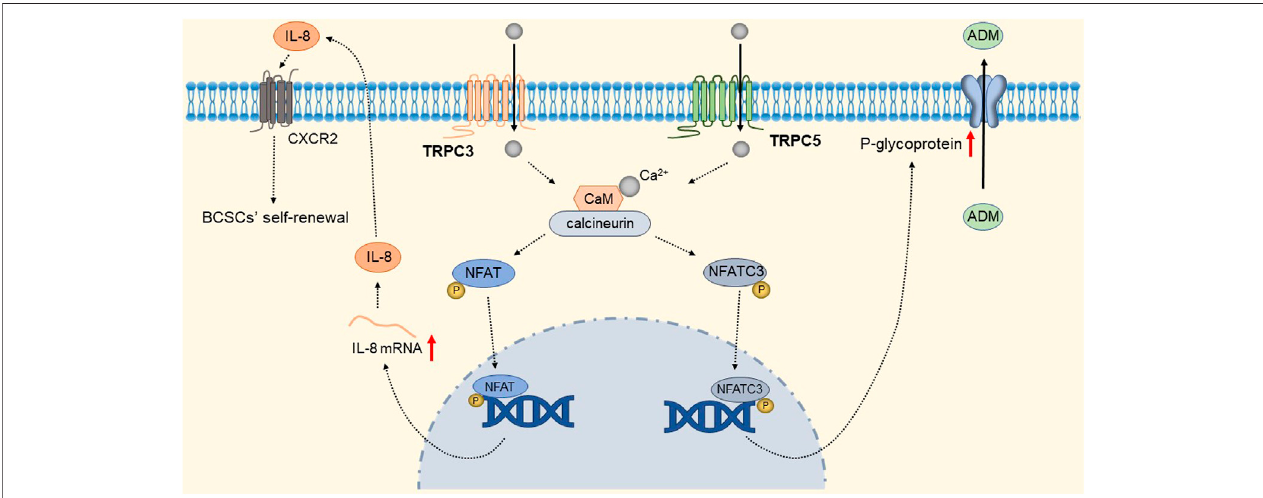
FIGURE 10 | TRPC3andTRPC5mediatebreastcancercellproliferationanddrugresistance.Ca 2+ entrythroughTRPC3andTRPC5channels,viacalmodulin-calcineurin dependent NFAT signal pathway, upregulating IL-8 and P-gp expression respectively. IL-8 mediates BCSC proliferation through CXC receptor 2. Up-regulated P-gp expels intracellular ADM into the extracellular matrix, leading to drug